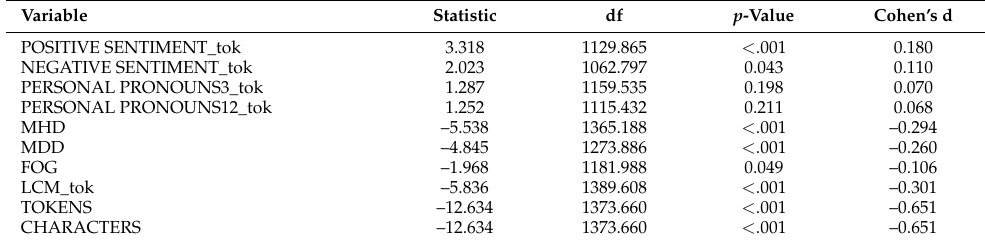
Table 4. Independent Welch t-test for differences between credible and non-credible statements.